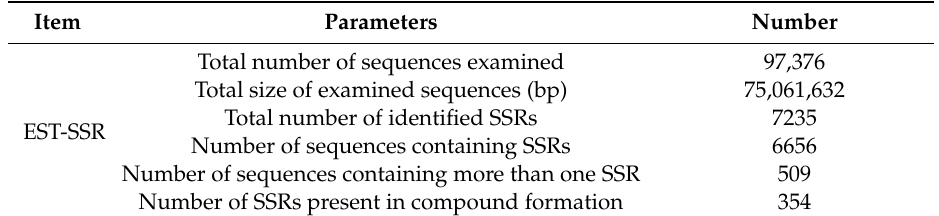
Table 1. Summary of analyses of expressed sequence tag–simple sequence repeat (EST-SSRs) in Pinus koraiensis